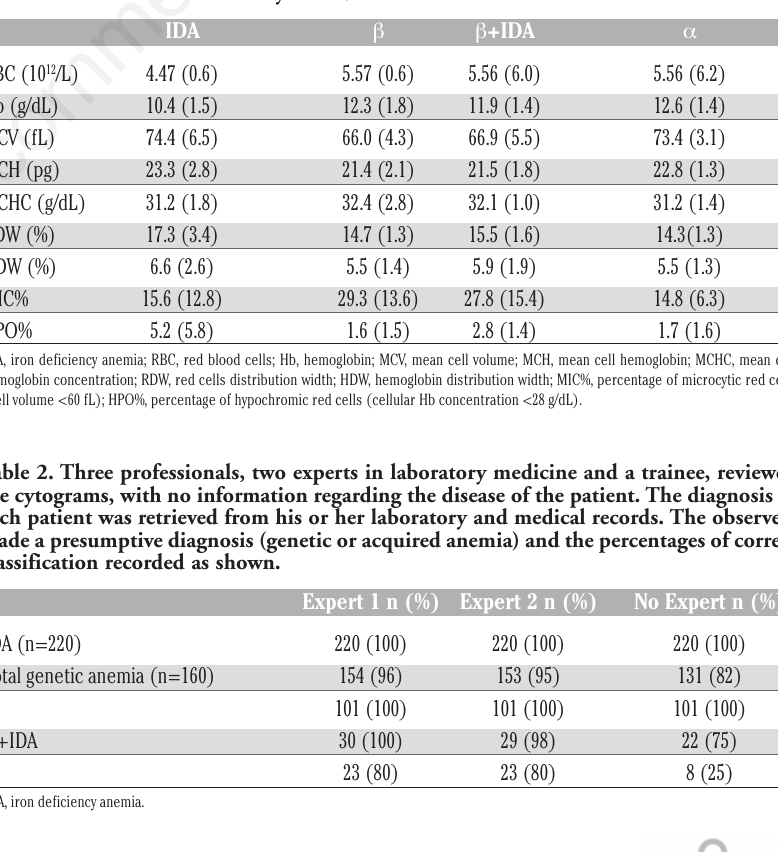
Table 1. Results (mean and standard deviation) of red blood cells parameters in the group of patients: 220 iron deficiency anemia, 101 b -thalassemia trait, 30 b -thalassemia trait with concomitant iron deficiency and 29 a -thalassemia trait.